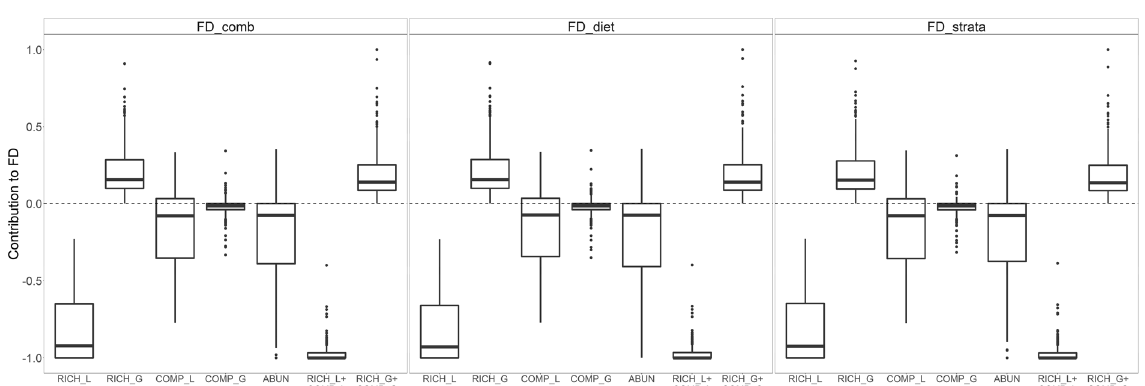
Figure 2. Relative contribution of the Price Equation components describing changes in species assortment, to functional diversity (FD), calculated from three different functional trait sets (FD_comb, FD_diet, FD_strata; see main text for